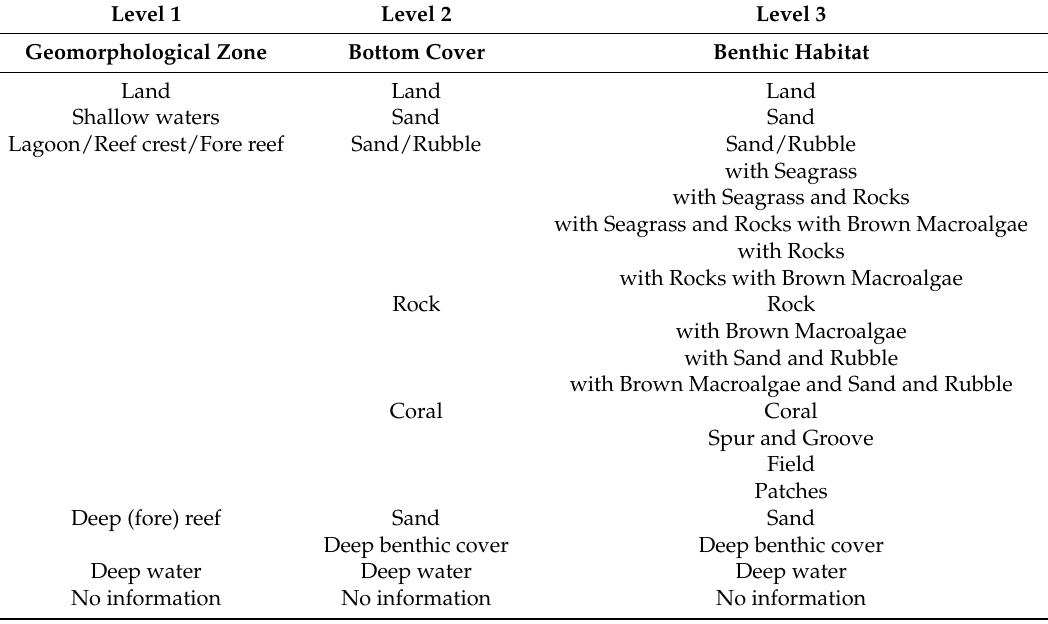
Table 4. Three level hierarchical habitat classification scheme applied in the Lund mapping production